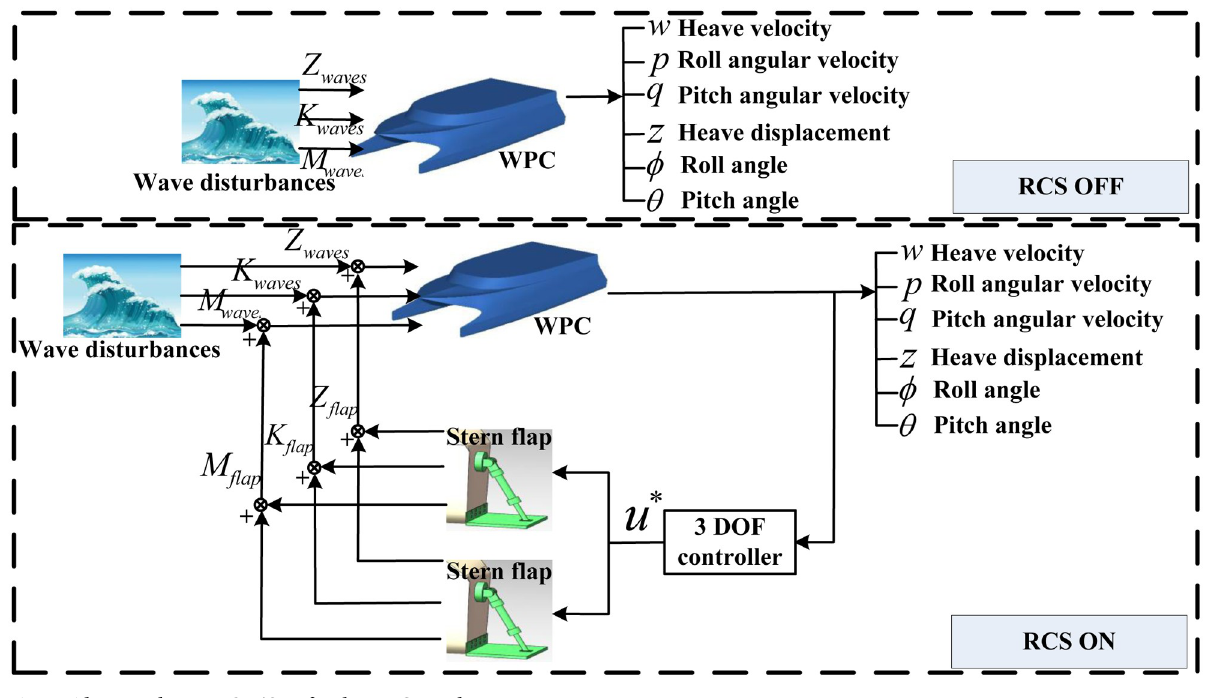
Fig 9. Ride control system ON/OFF for the WPC